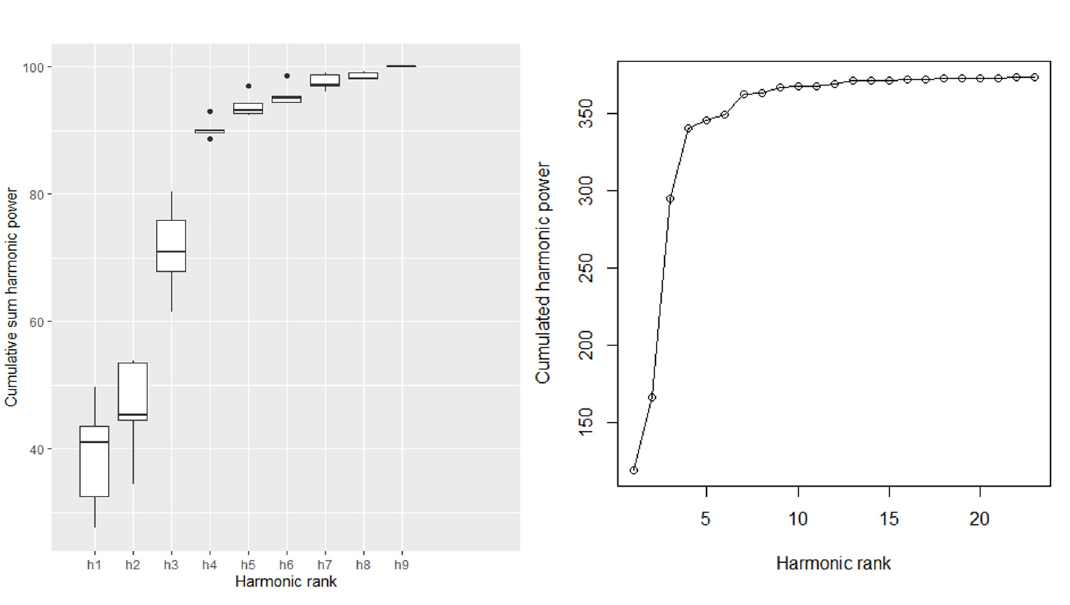
Figure 7: Cumulative harmonic power calculated using the “ calibrate_harmonicpower_efourier ” function. 99% of harmonic power is captured in the fi rst 10 harmonics ( 110 outlines ) ( 6 = 90%, 7 = 95%, 10 = 99% )